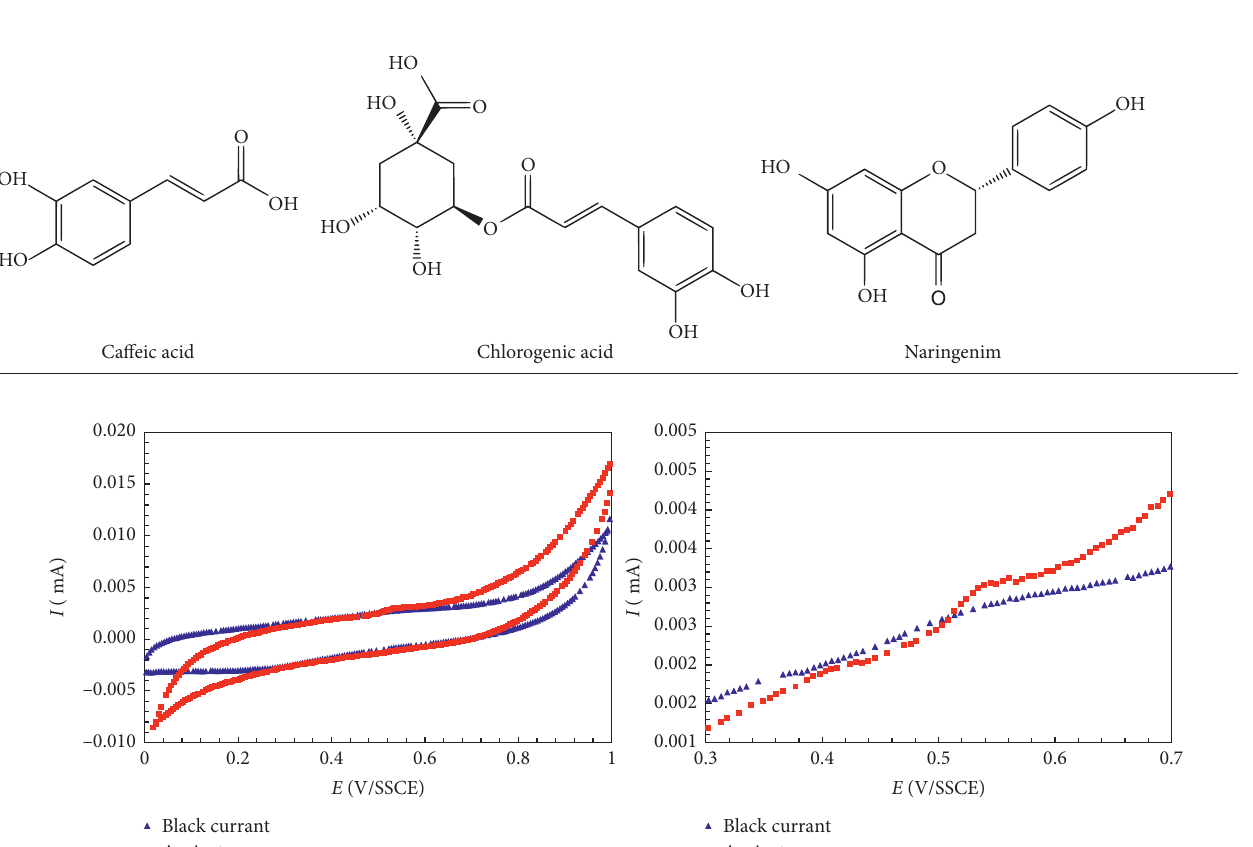
Table 2: Chemical structures of the common chemical constituents of black currant and apricot pomace extract.